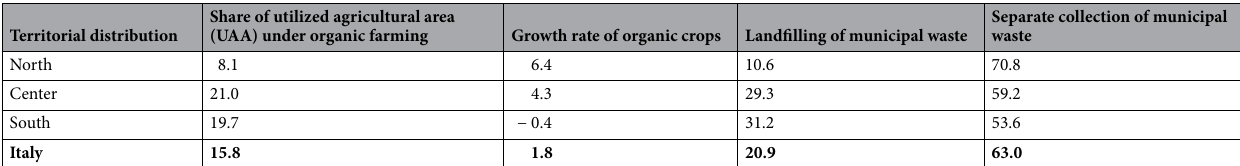
Table 2. M2C1 indicators—Circular economy and sustainable agriculture by territorial distribution (year 2019). Source : our elaboration on SDGs. National values are in bold.